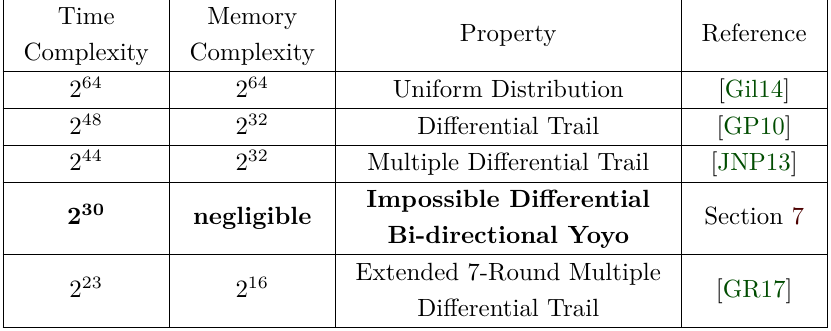
Table 3: 8-round Known-Key Distinguishers on